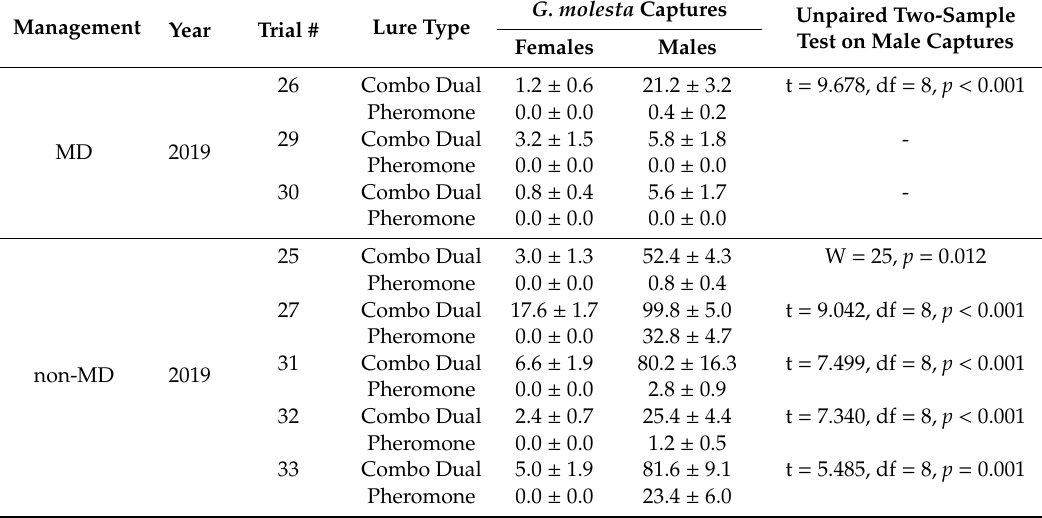
Table 7. Grapholita molesta captures in eight trials of lure comparison conducted in mating disruption (MD)-treated and -not treated peach and nectarine orchards in Italy during post-harvest in 2019. Mean ( ± SEM) of total moth captures over 6–8 weeks of trial duration. Monitoring traps were either baited with Pherocon ® OFM Combo Dual (Combo Dual) or Pherocon ® OFM L 2 (Pheromone), both Tr é c é Inc. lures.